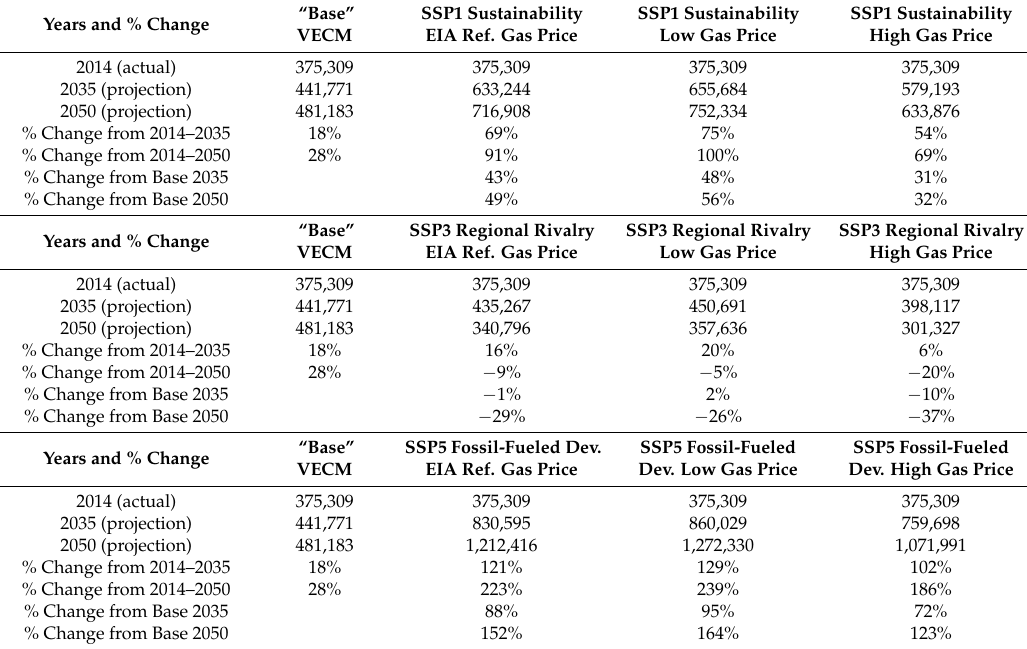
Table 4. Model Results for Future Ethylene Supply (thousand barrels per year).